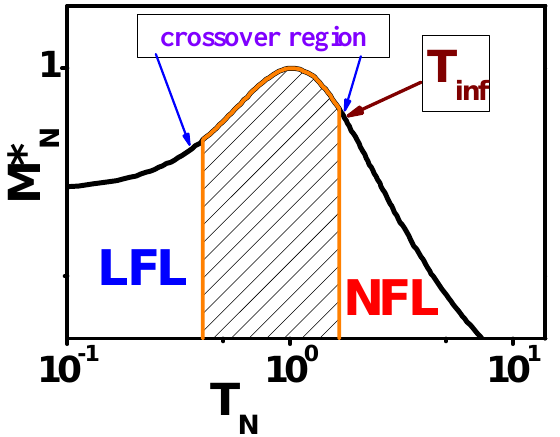
FIG. 5: The properties of the specific heat. (a) The maximum values of ( C mag /T ) max of the specific heat C mag /T versus magnetic field B are shown by the solid squares, see the inset, Fig. 1. The solid curve is approximated by M ∗ ( B ) B − 2 / 3 = M ∗ / M ∗ versus the normalized max N M ∝ in accordance with Eq. (5). The arrow depicts the position = 1 at reaches its maximum M ∗ N N of ( C mag /T ) max at B = 0 when the impurity Schottky contri- bution is subtracted [23]. (b) The temperature T max ( B ), at which the maxima of ( C mag /T ) are located, see Fig. 3 (a). The solid straight line traces the function T max B , see Eq. ∝ (7).